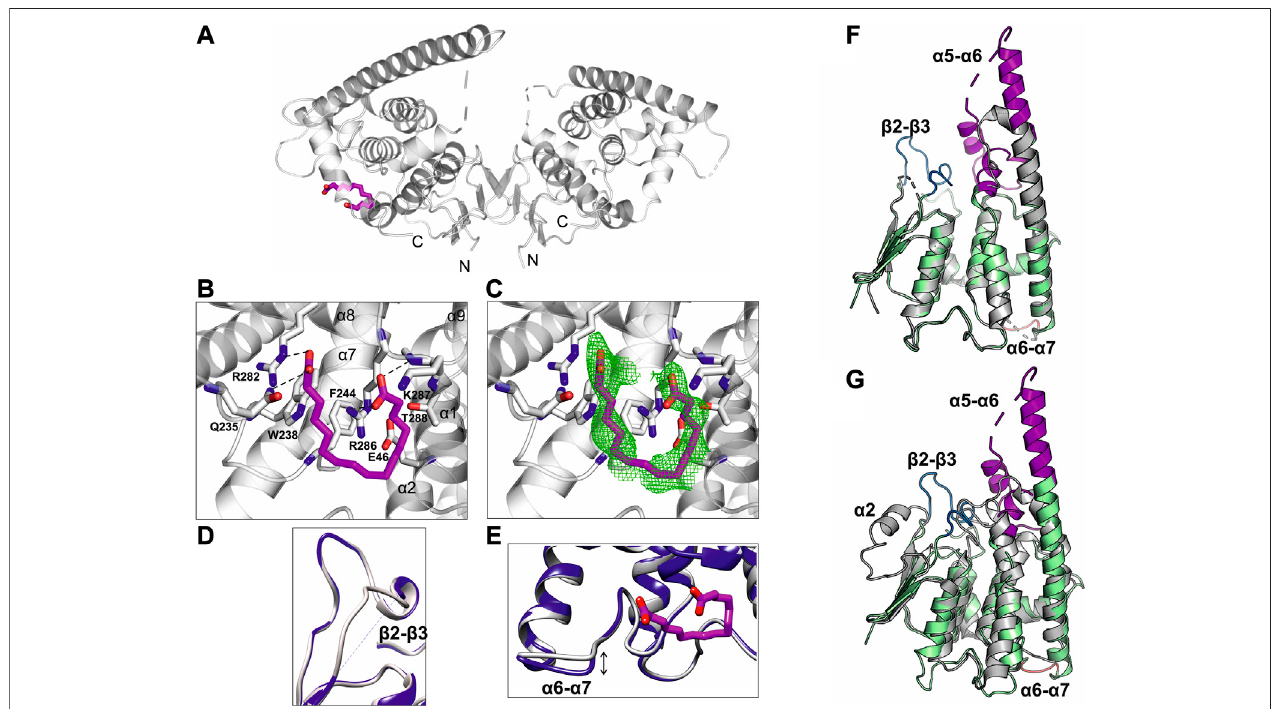
FIGURE 5 | Crystal structure of GDAP1 Δ 303-358 in complex with HA. (A) Overall structure of the GDAP1-HA complex. The dashed line indicates a loop not resolved in electron density. HA is shown in magenta. (B) HA interacting residues, hydrogen bonds are shown as dashed lines. (C) HA ligand of GDAP1 overlaid with Polder map (5 σ , green). (D) Superposition the loop β 2- β 3 of apo GDAP1 (blue) and the HA complex (grey). The dashed line indicates a loop not resolved in electron density. (E) Superposition of the loop α 6- α 7 of apo GDAP1 (blue) and the HA complex (grey).HA is shown in magenta. (F) Superposition ofhuman GDAP1 (green) andmouseGDAP1(Googinsetal.,2020)(grey).Thedashedlinesindicateloopsnotresolvedinelectrondensity.Themobileloopsinclude β 2- β 3(blue), α 5- α 6(magenta), and α 6- α 7 (brown). (G) Superposition of human GDAP1 (green) and Sj GST (Kursula et al., 2005) (grey). The dashed lines indicate loops not resolved in electron density. The mobile loops include β 2- β 3 (blue), α 5- α 6 (magenta), and α 6- α 7